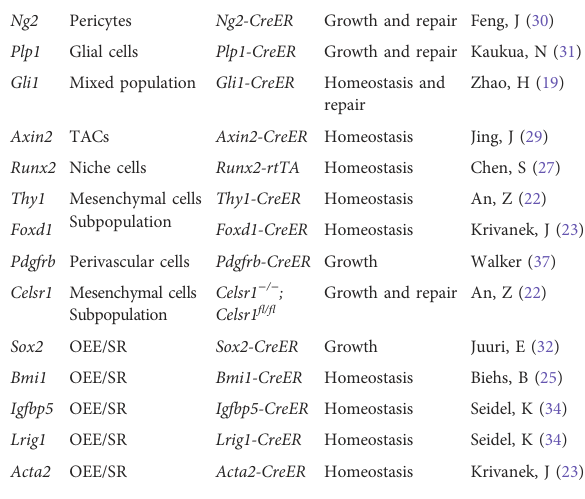
Table 1 Stem cell and niche cell populations identi fi ed in the mouse